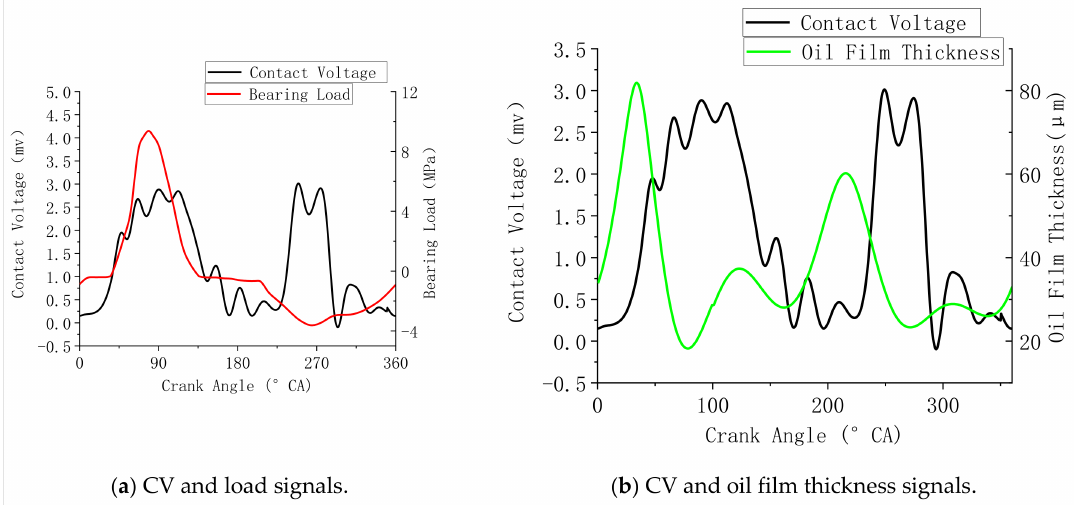
Figure 10. Comparison of different signals of copper alloy (1500 r/min, 10 MPa).